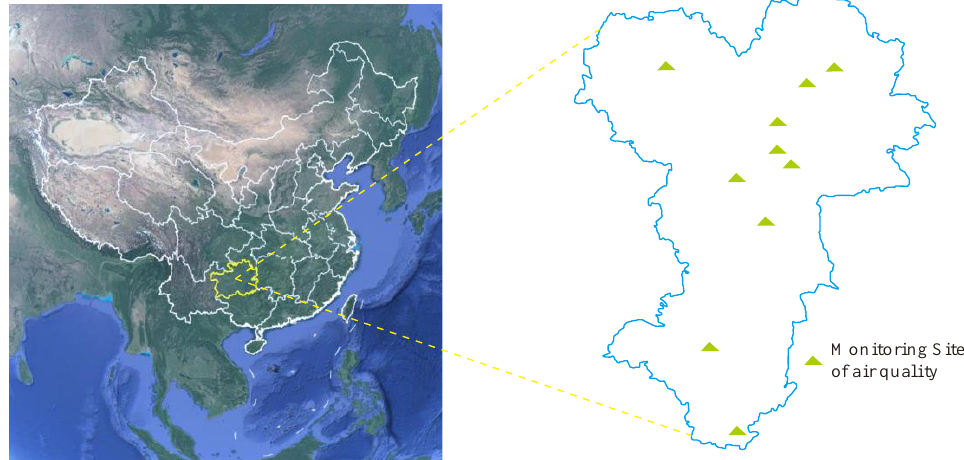
Figure 1. Geographical location of Guiyang city and its distribution of air quality stations (based on Google Earth).